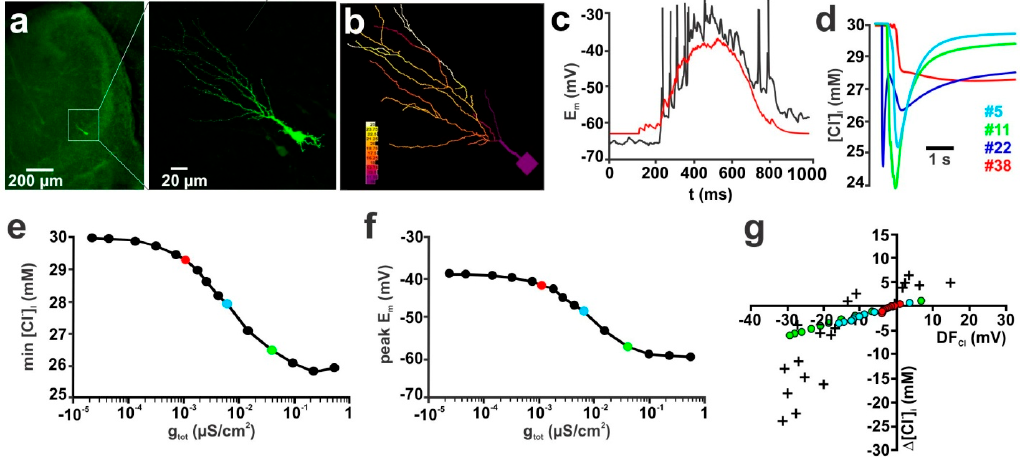
Figure 2. Passive membrane conductance (g pas ) influences GABA-induced [Cl ⁻ ] i transients in a reconstructed CA3 pyramidal neuron. Similar to the simulations in the isolated dendrite (Figure